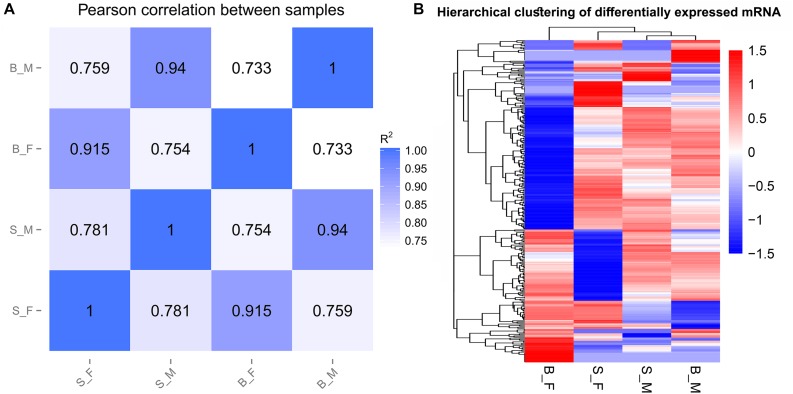
Sample relationships revealed by two different approaches. (A) Pearson’s correlation analysis between samples. The figures in the matrix R2 are the squares of the correlation coefficient (r) between two samples. (B) Hierarchical clustering based on the relative FPKM values [log10(FPKM + 1)] of all genes; scaling was done across all samples for each gene.